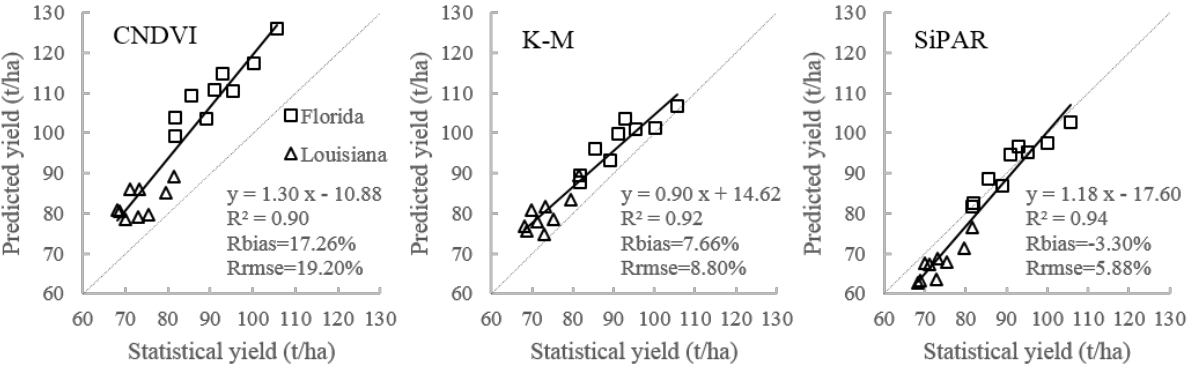
Figure 7. The predicted yield against statistical yield at the state level.